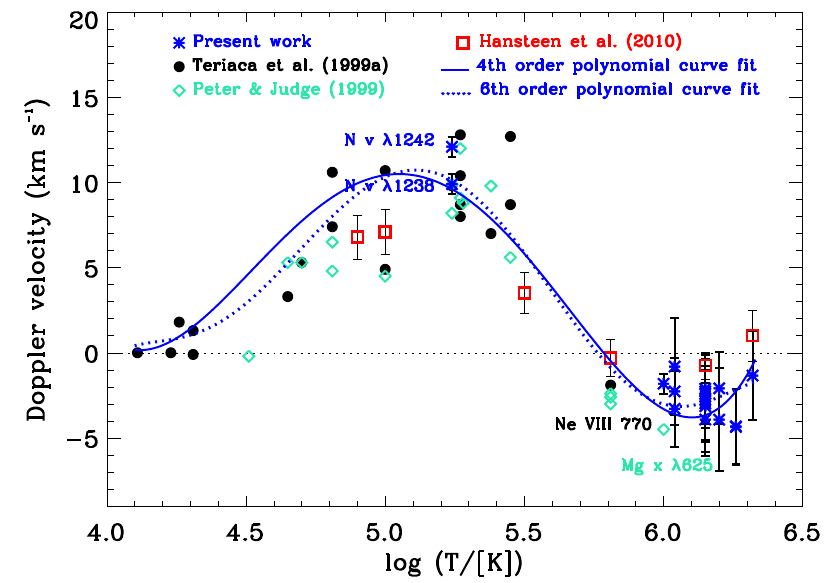
Figure 10: Average Doppler shift in the quiet Sun at disk center of various TR and coronal ions measured from SUMER and EIS spectra. Positive/negative values indicate red- (downflows) / blue- (upflows) shifts. Solid and dashed lines respectively represent polynomial fittings. Image reproduced with permission from Dadashi et al. (2011), copyright by